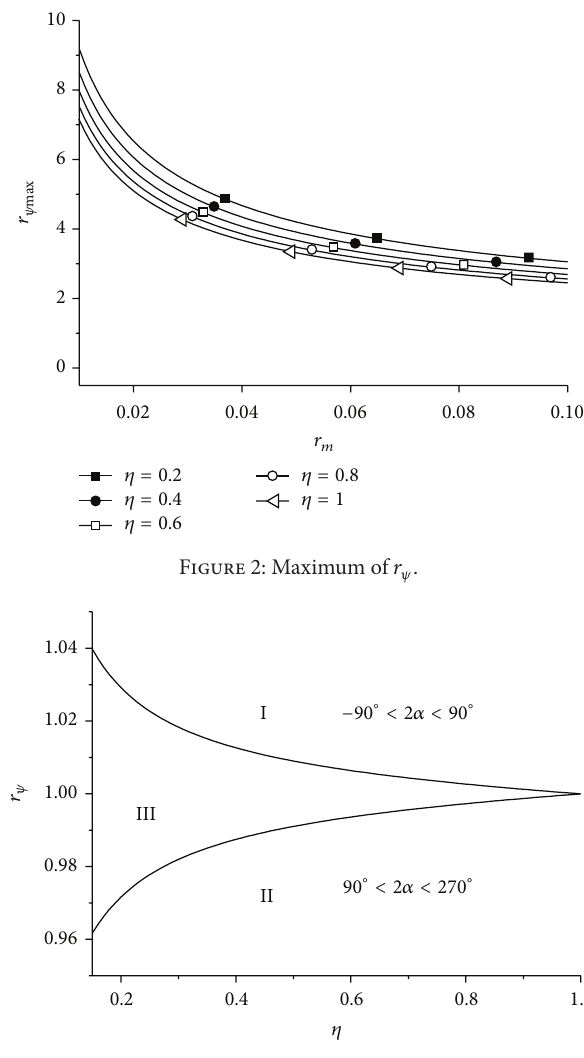
Figure 2: Maximum of 𝑟 𝜓 .